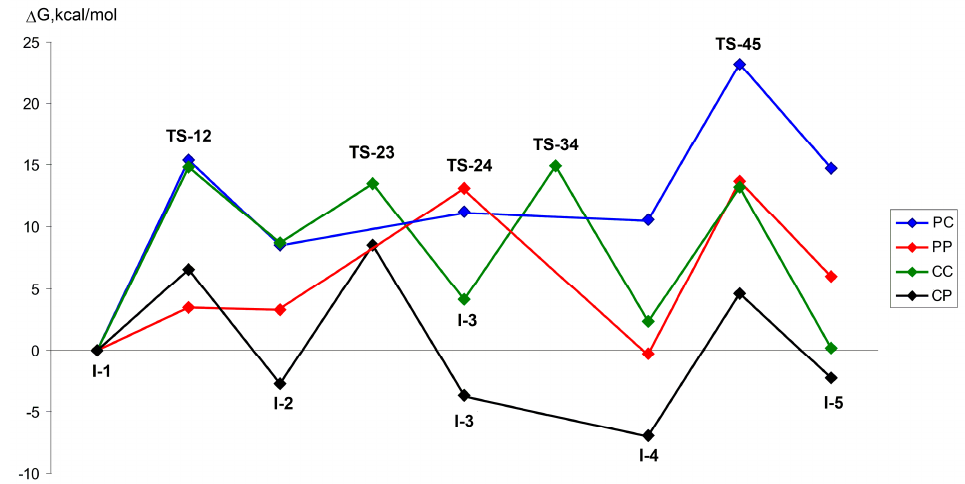
Figure 2. Calculated free energy profiles for all comonomer sequences of ε -CL / M e OEP copolymerization based on data obtained earlier [26,46] and in this work.